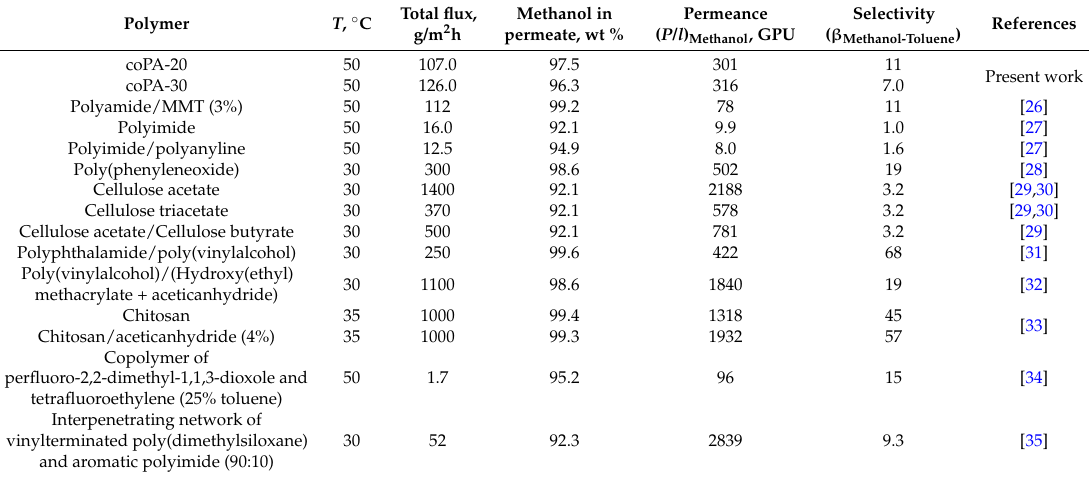
Table 2. Comparison of transport properties of the present coPA films with literature data on pervaporation of methanol–toluene (70:30 wt %)